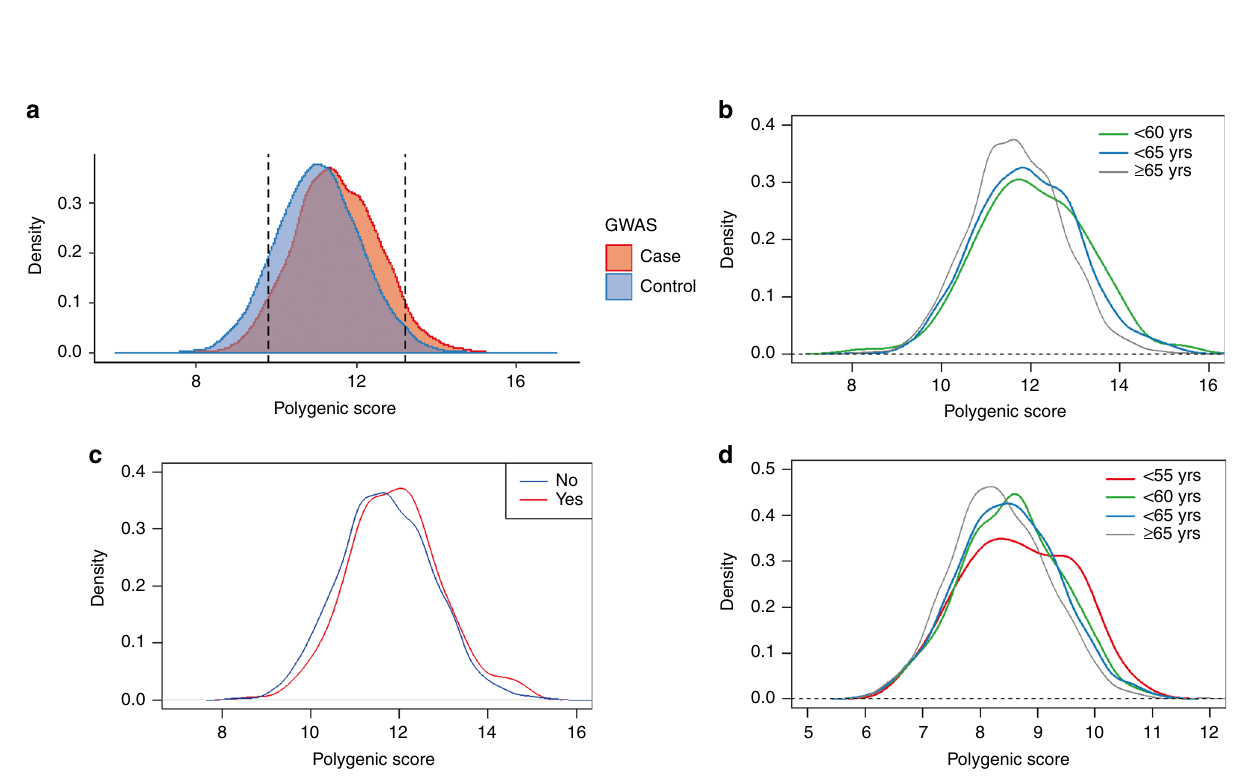
Fig. 4 The distribution of the polygenic risk score (PRS) for PCa in Japanese population. a The PRS distribution of the PCa cases ( n = 4893) and the male control ( n = 10,682) of GWAS. Density was estimated using the Gaussian kernel. The 5% higher and lower percentiles are shown as dotted lines. b The PRS distribution by the age at diagnosis of PCa in the GWAS cases ( n = 4762). Density was estimated using the Gaussian kernel. Green, younger than 60 years ( n = 129); blue, younger than 65 years ( n = 781); gray, 65 years or older ( n = 3852). c The PRS distribution by the presence of PCa family history in the GWAS cases ( n = 4893). Density was estimated using the Gaussian kernel. Red, positive PCa family history ( n = 272); blue, negative PCa family history ( n = 4621). d The PRS distribution by the age at diagnosis of PCa in the JIKEI validation cohort ( n = 2218). Density was estimated using the Gaussian kernel. Red, younger than 55 years ( n = 94); green, younger than 60 years ( n = 310); blue, younger than 65 years ( n = 802); gray, 65 years